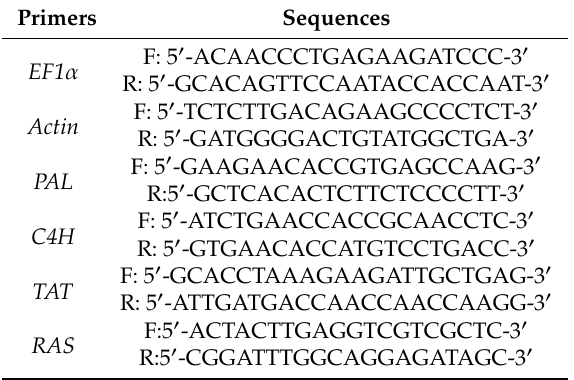
Table 1. Primers for housekeeping genes and specific primers for Salvia o ffi cinalis . Primers